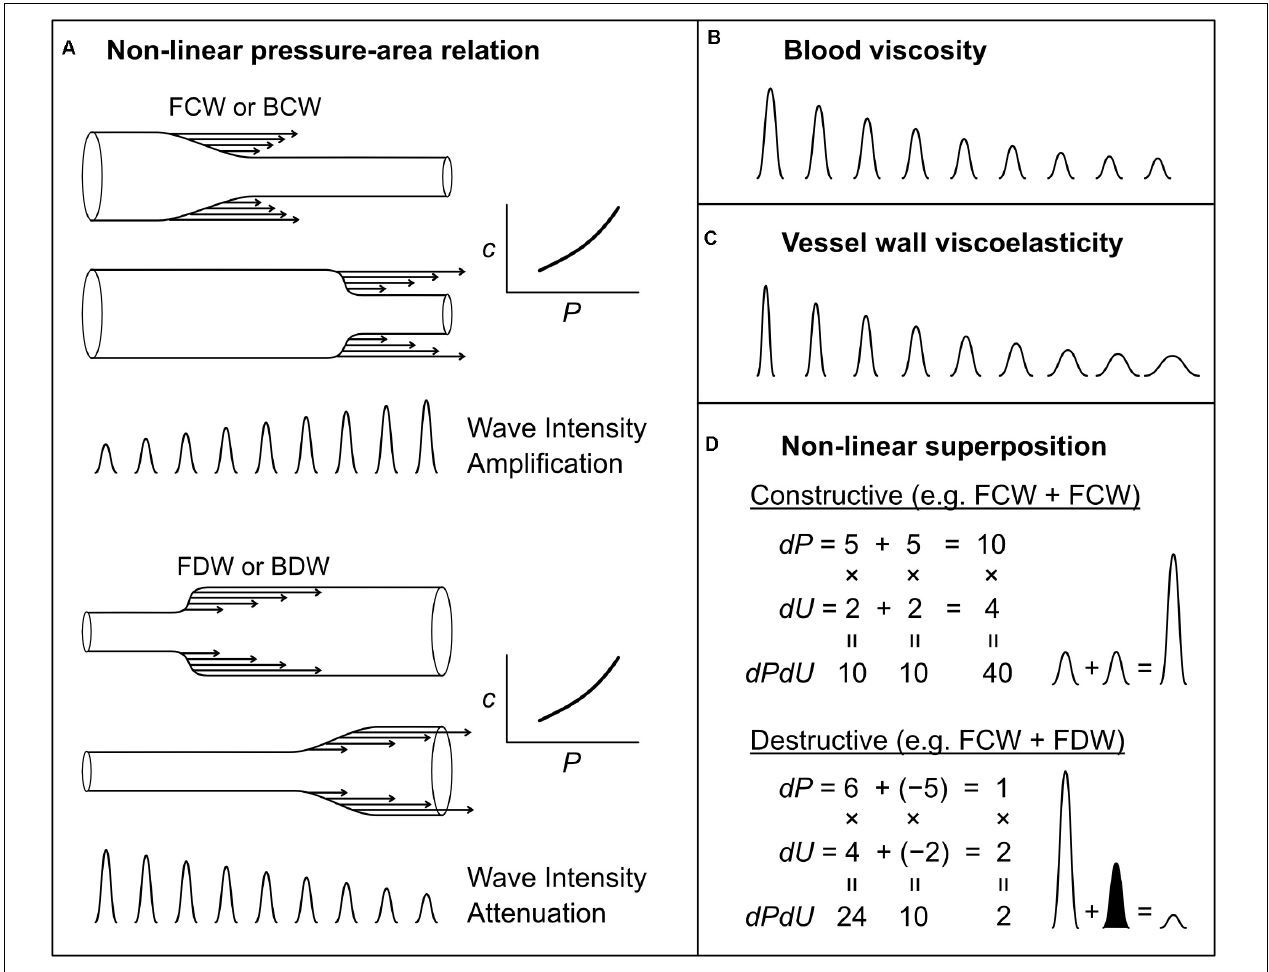
FIGURE 8 | Mechanisms that affect wave intensity magnitude as a wave propagates (A–C) or when two waves propagating in the same direction, but generated from separate mechanisms, combine constructively or destructively (D) . Waves shown in (B,C) could be any wave type (FCW, FDW, BCW, or BDW). In the examples of wave superposition shown in (D) , the shaded and unshaded waves indicate an FDW and FCW,